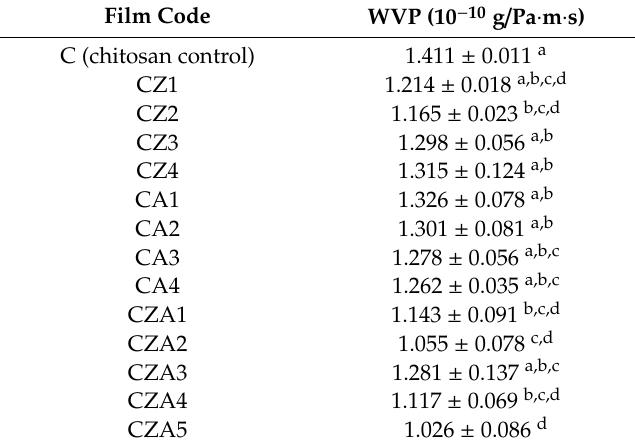
Table 6. Water vapor permeability (WVP) for control, CZ, CA, and CZA